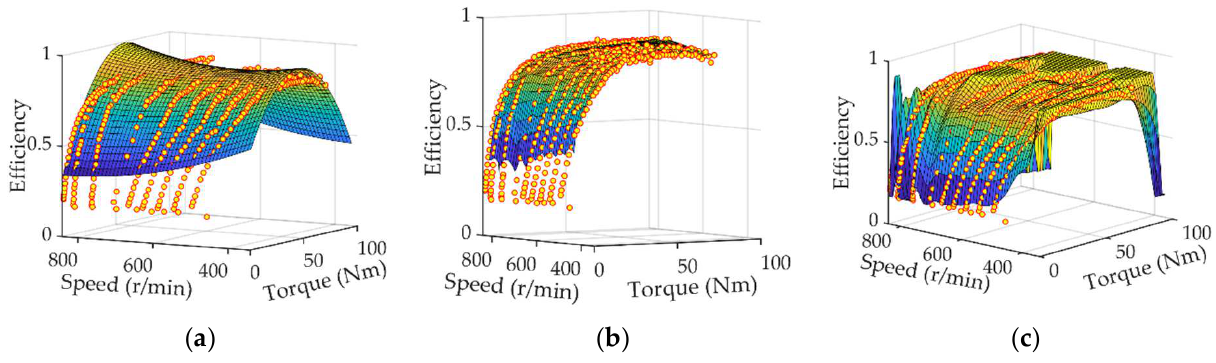
Figure 9. The comparison of precision of motor efficiency models in full working conditions. ( a ) Polynomial Regression; ( b ) Bilinear Interpolation method; ( c ) Radial Basis Kernel Function Neural Network.